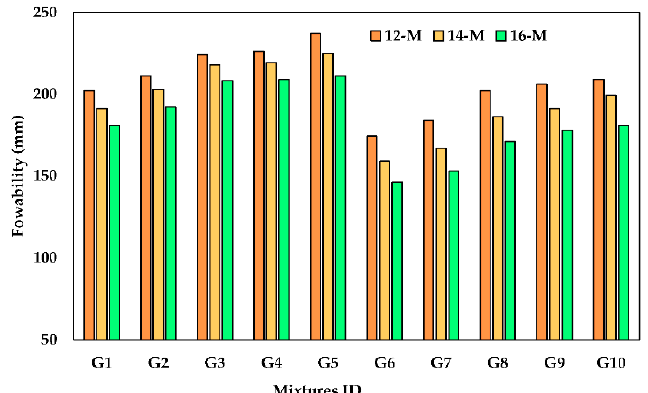
Figure 4. Effect of KOH molarity and ASM type on the slump flow diameter.